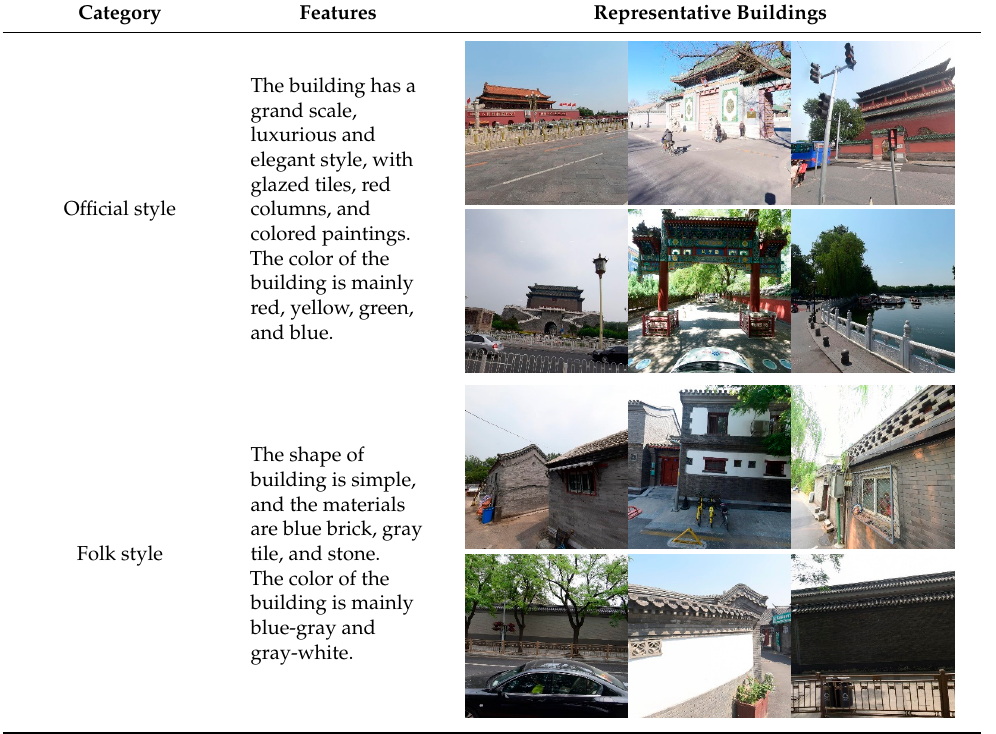
Table 1. Description of building category.